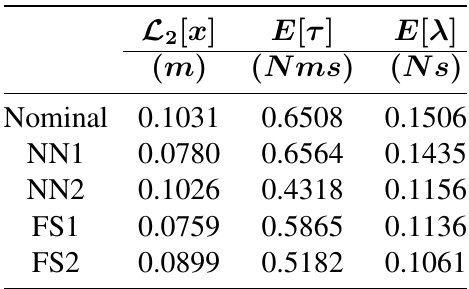
Table 4. Performance